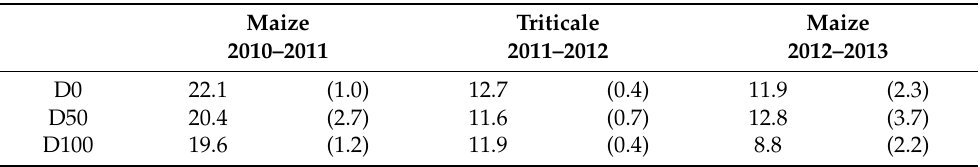
Table 3. Maize and triticale above-ground biomass (t dry weight ha − 1 ) under different experimental treatments (means followed by standard error in brackets). Maize Triticale Maize